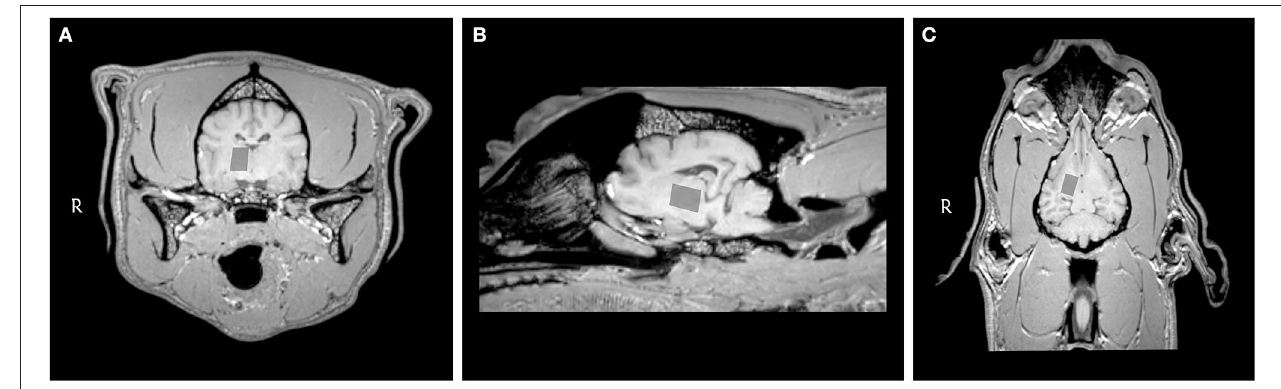
FIGURE 4 | Transverse (A) , sagittal (B) , and dorsal (C) T1-weighted MRI images of the brain of a dog with idiopathic epilepsy showing the location of the voxel of interest in the right part of the thalamus.